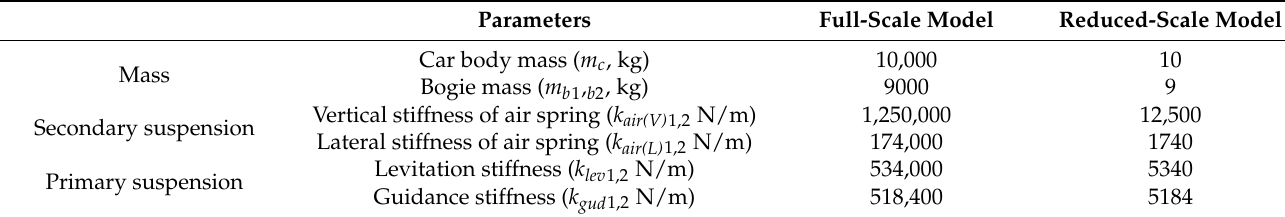
Table 1. Design parameters for the vehicle model.